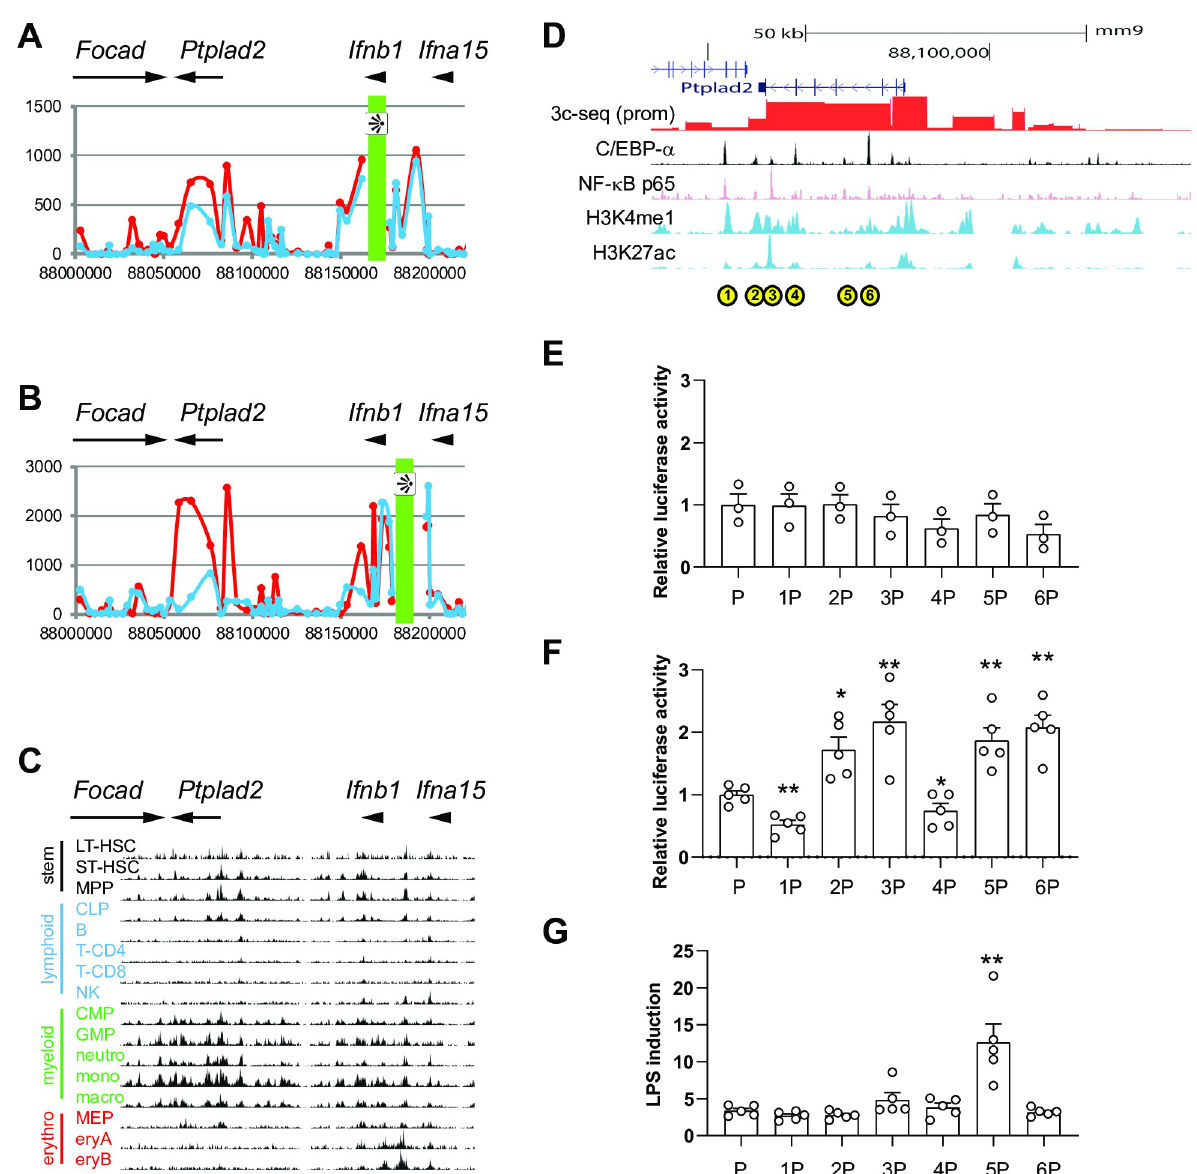
Fig 1. The murine Ifnb1 gene loops to a myeloid super-enhancer in Ptplad2 . ( A and B ) 3c-seq analysis of the Ptplad2 / Ifnb1 locus using ( A ) Ifnb1 or ( B ) the ICE regulatory region as viewpoints in activated WT (blue line) or Trim33 -/- (red line) macrophages. Genes are indicated above the graph, and position on chromosome 4 (mouse genome version mm9) is indicated below the graph. ( C ) Normalized signal from H3K4me1 ChIP-seq experiments performed in hematopoietic sub-populations (B: B lymphocytes, CLP: common lymphoid progenitors, CMP: common myeloid progenitors, eryA: erythroblasts A, eryB: erythroblasts B, GMP: granulocyte monocyte progenitors, LT-HSC: long term hematopoietic stem cells, macro: macrophages, MEP: megakaryocyte erythrocyte progenitors, mono: monocytes, MPP: multipotent progenitors, neutron: neutrophils, NK: natural killer cells, ST-HSC: short term hematopoietic stem cells, T-CD4: CD4+ T lymphocytes, T-CD8: CD8+ T lymphocytes). Data from [40]. ( D ) Signal from ChIP-seq experiments targeting different transcription factors and histone marks over the Ptplad2 gene. The results of the 3C-seq experiment from the Ifnb1 promoter viewpoint is shown in red. Identified enhancers are indicated with yellow circles, and numbered. Data from [41] (C/EBP α ), [42] (NF- κ B p65), and [43] (H3K4me1 and H3K27ac). ( E ) Plasmids encoding firefly luciferase under the control of the Ifnb1 promoter (P) flanked or not with the enhancers identified above, each labelled with its number, were transfected into NIH3T3 cells together with a plasmid coding for Renilla luciferase under the CMV promoter. After 30 hrs, luciferase levels were measured. Results are expressed as the ratio of firefly to Renilla luciferase, normalized to the mean value of P. ( F ) Plasmids encoding firefly luciferase under the control of the Ifnb1 promoter (P) flanked or not with the enhancers identified above, each labelled with its number, were transfected into RAW264.7 cells together with a plasmid coding for NanoLuc luciferase under the thymidine kinase promoter. After 30 hrs, luciferase levels were measured. Results are expressed as the ratio of firefly to NanoLuc luciferase, normalized to the mean value of P. ( G ) Same experiment as in F , except that RAW264.7 cells were treated or not with 100 ng/ml LPS for the last 8 hrs. Results are expressed as the ratio of relative luciferase activity between LPS treated versus non-treated cells. For ( E ), ( F ) , and ( G ) , results are presented as mean ± s.e.m with open circles showing individual values, each in triplicate (n = 3 to 5). � : p < 0.05; �� : p < 0.01 (two-sided ratio paired t